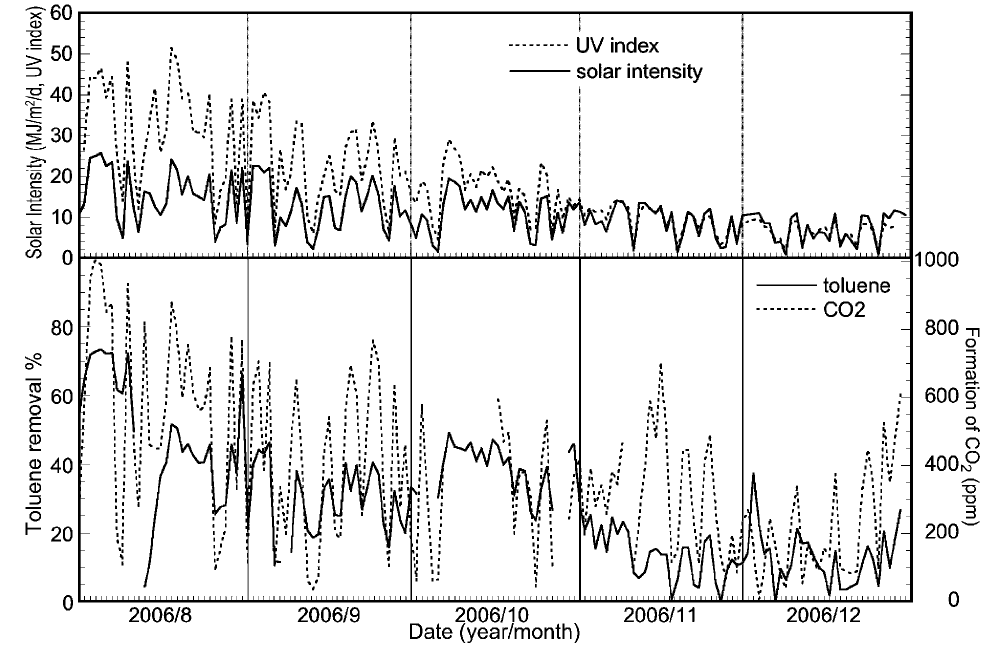
Figure 4. Plots of the integrated values for toluene removal ratio, the concentration of CO 2 product and the solar intensity per day for five months obtained using the reactor installed with a TiO 2 -coated ceramic